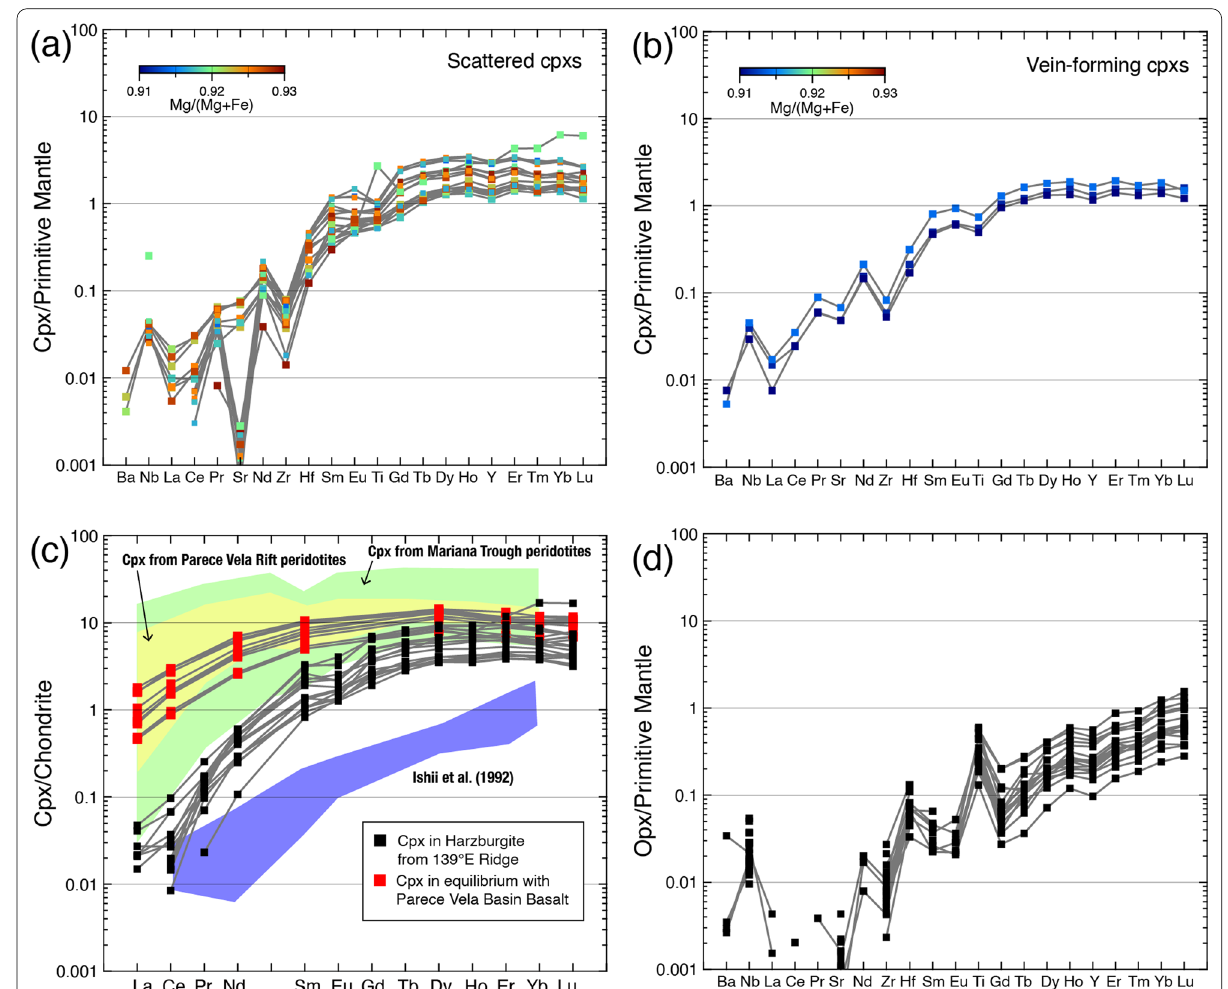
Fig. 9 Primitive‑mantle‑normalized incompatible element patterns for a scattered clinopyroxenes and b vein‑forming clinopyroxenes in the 139°E Ridge peridotites. The colors indicate the Mg# values of clinopyroxene. Primitive mantle values are from McDonough and Sun (1995). c Chondrite‑normalized rare earth element patterns for clinopyroxenes. Chondrite values are from Anders and Grevesse (1989). Black dots indicate clinopyroxenes of the 139°E Ridge peridotites. Red dots indicate calculated clinopyroxenes in equilibrium with Parece Vela Basin basalt (Ishizuka et al. 2010). Yellow field is clinopyroxene from Parece Vela Rift peridotites (Ohara et al. 2003), whereas green field is clinopyroxene from Mariana Trough peridotites (Ohara et al. 2002a, b). The blue field is clinopyroxene from Mariana forearc (Ishii et al. 1992). The partition coefficients between clinopyroxene and melt are from Hart and Dunn (1993). d Primitive‑mantle‑normalized incompatible element patterns for orthopyroxenes of the 139°E Ridge peridotites. Primitive mantle values are from McDonough and Sun